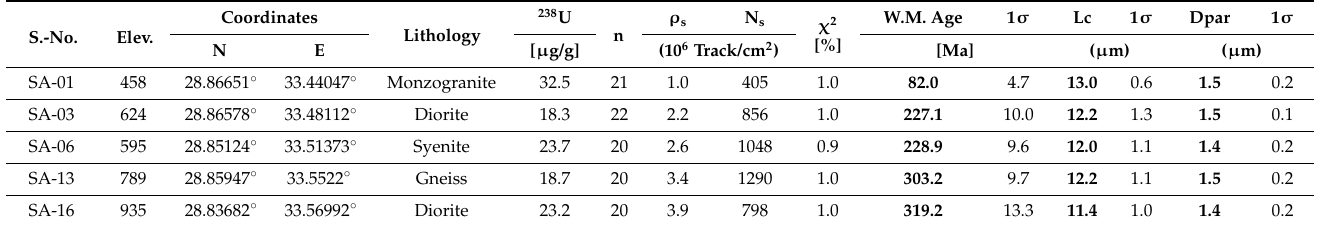
Table 2. Apatite fission-track ages, data, and sample